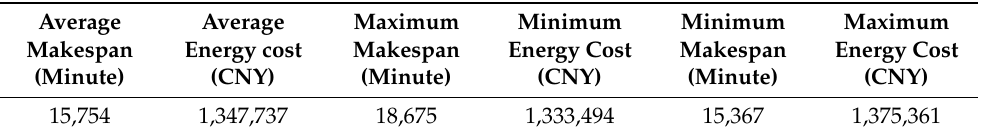
Table 13. The average, maximum, and minimum value of energy cost and makespan obtained by